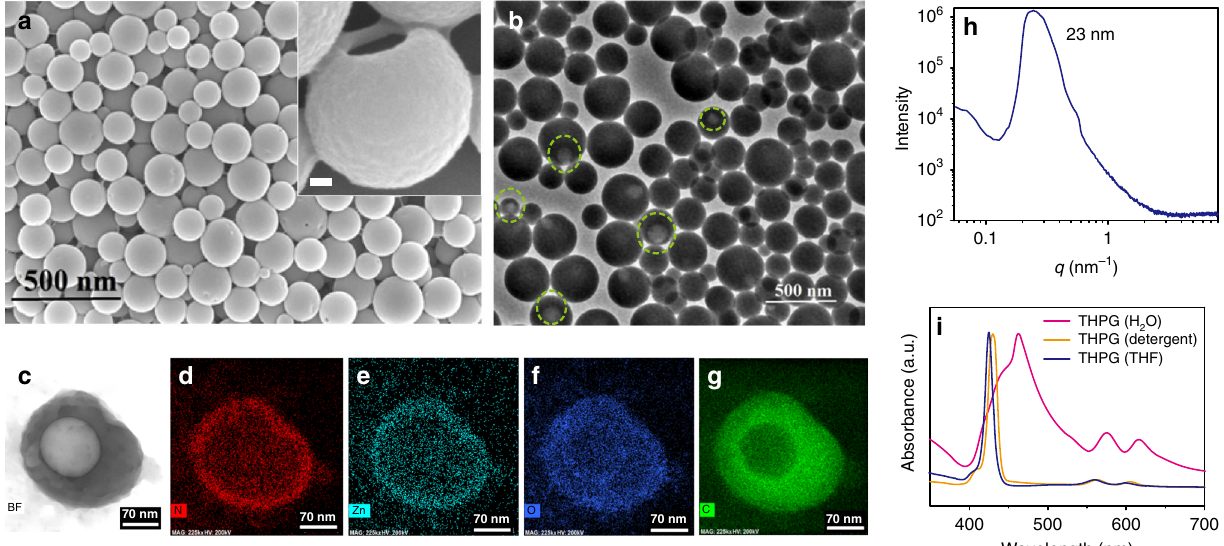
Fig. 2 Characterizations of THPG vesicles. a The representative SEM image of THPG vesicles. The scale bar in the inset is 30 nm. b The representative TEM image of THPG vesicles, light green circles indicated the broken particles featured with bright openings. Similar SEM and TEM images of THPG were obtained for more than three times experiments. c The representative STEM image and corresponding elemental mapping images of nitrogen ( d ), zinc ( e ), oxygen ( f ), and carbon ( g ) elements. h The SAXS spectrum of THPG vesicle solution at a concentration of 0.5 mg mL − 1 . i The UV – Vis spectra of THPGs in water, THF or 5% Triton X-100 detergent aqueous solution,